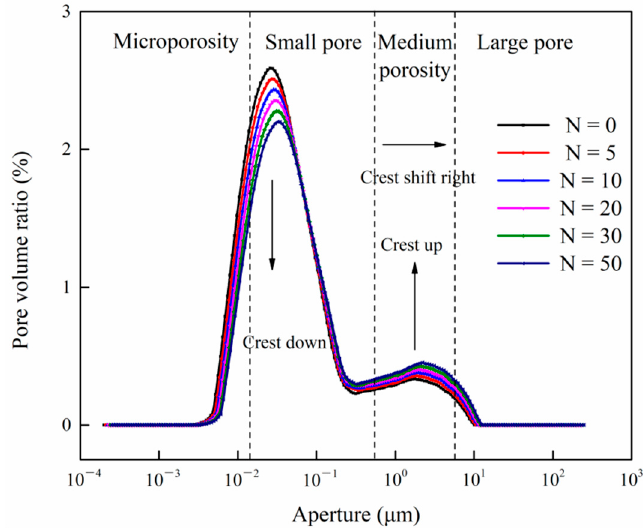
Figure 11. Pore distribution map of loess under freeze–thaw cycles.